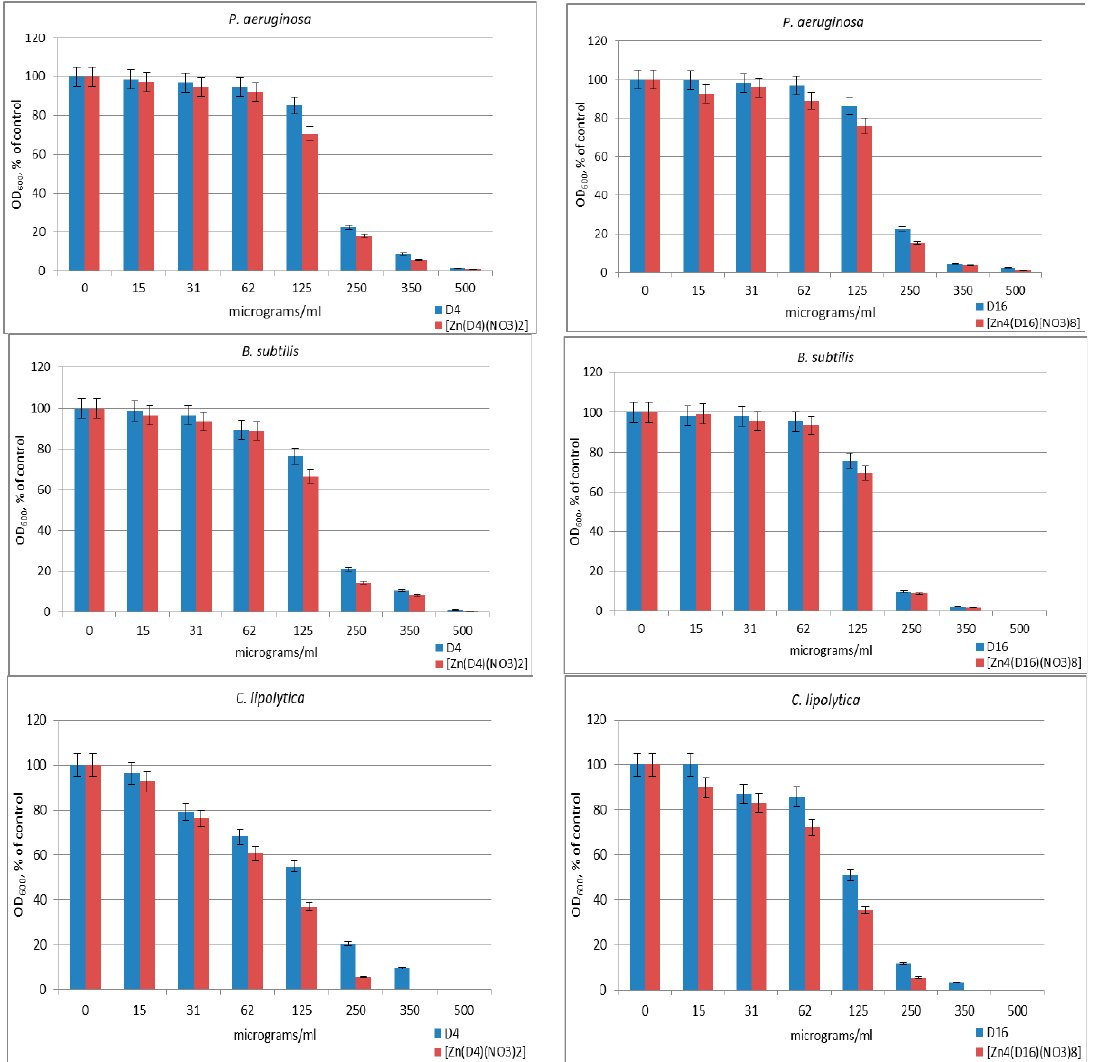
Figure 3. The effect of different concentrations of the dendrimer ligands (D4 and D16) and their complexes Zn(D4)(NO 3 ) 2 and Zn 4 (D16)(NO 3 ) 8 on the growth of the test model strains.